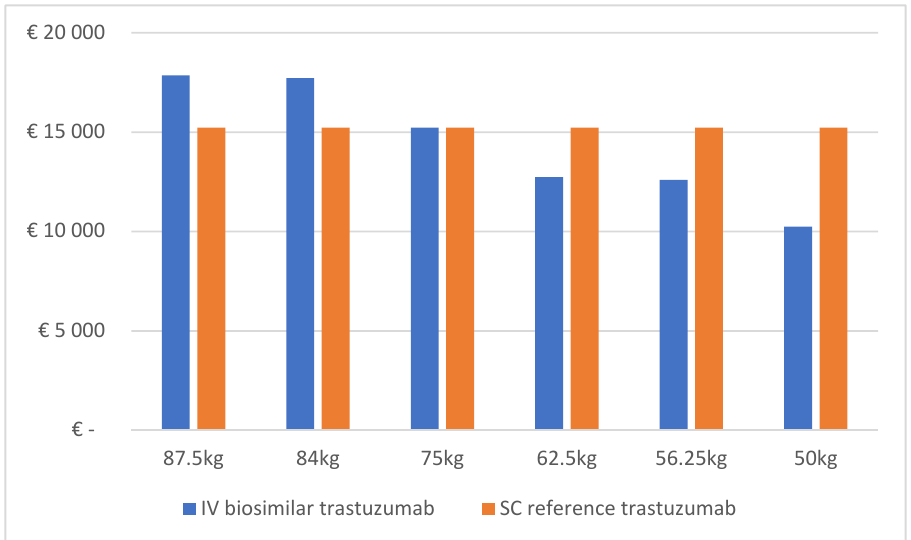
Figure 1. Drug costs for 1 year course of adjuvant treatment with IV biosimilar trastuzumab or with SC reference trastuzumab.